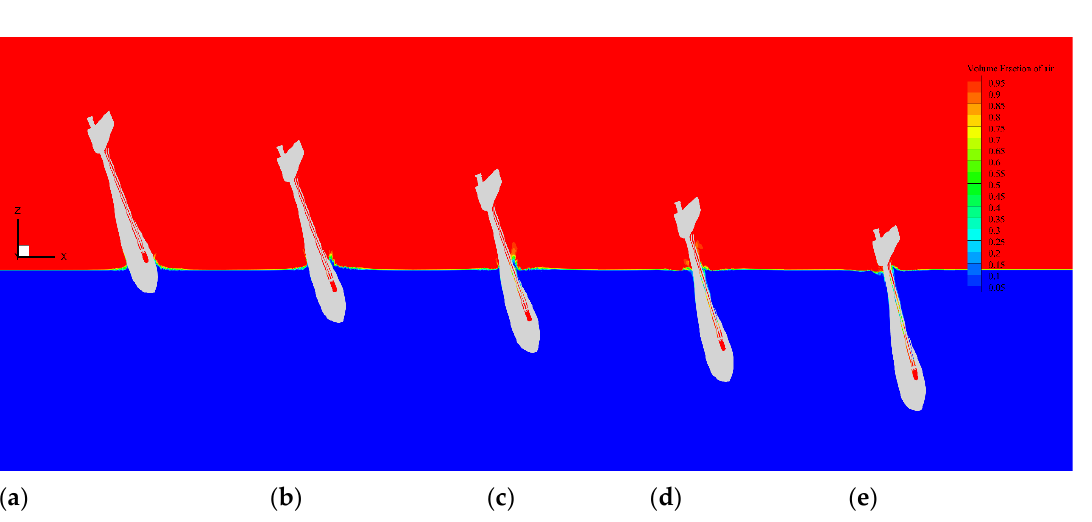
Figure 15. Free surface profiles of the vehicle entering water at θ 0 = 60° at different times: ( a ) t = 0.10 s, ( b ) t = 0.15 s, ( c ) t = 0.20 s, ( d ) t = 0.25 s, and ( e ) t = 0.30 s.